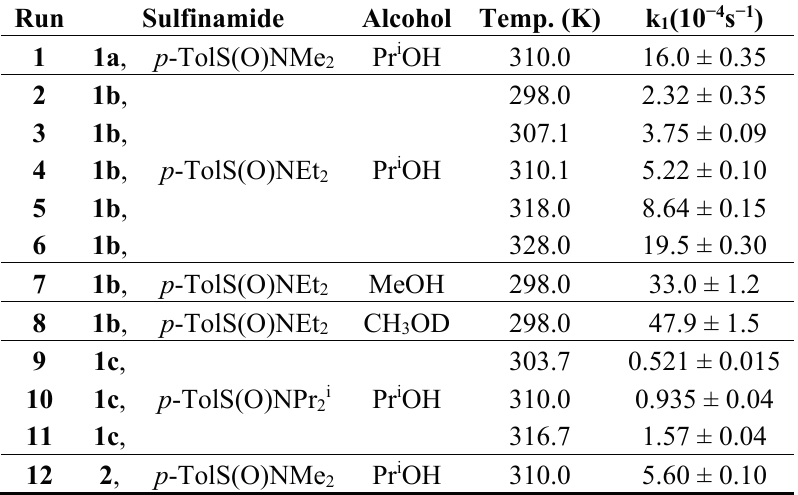
Table 8. Kinetic data on alcoholysis of arenesulfinamides, ArS(O)NR 1 R 2 , catalyzed by trifluoroacetic acid.